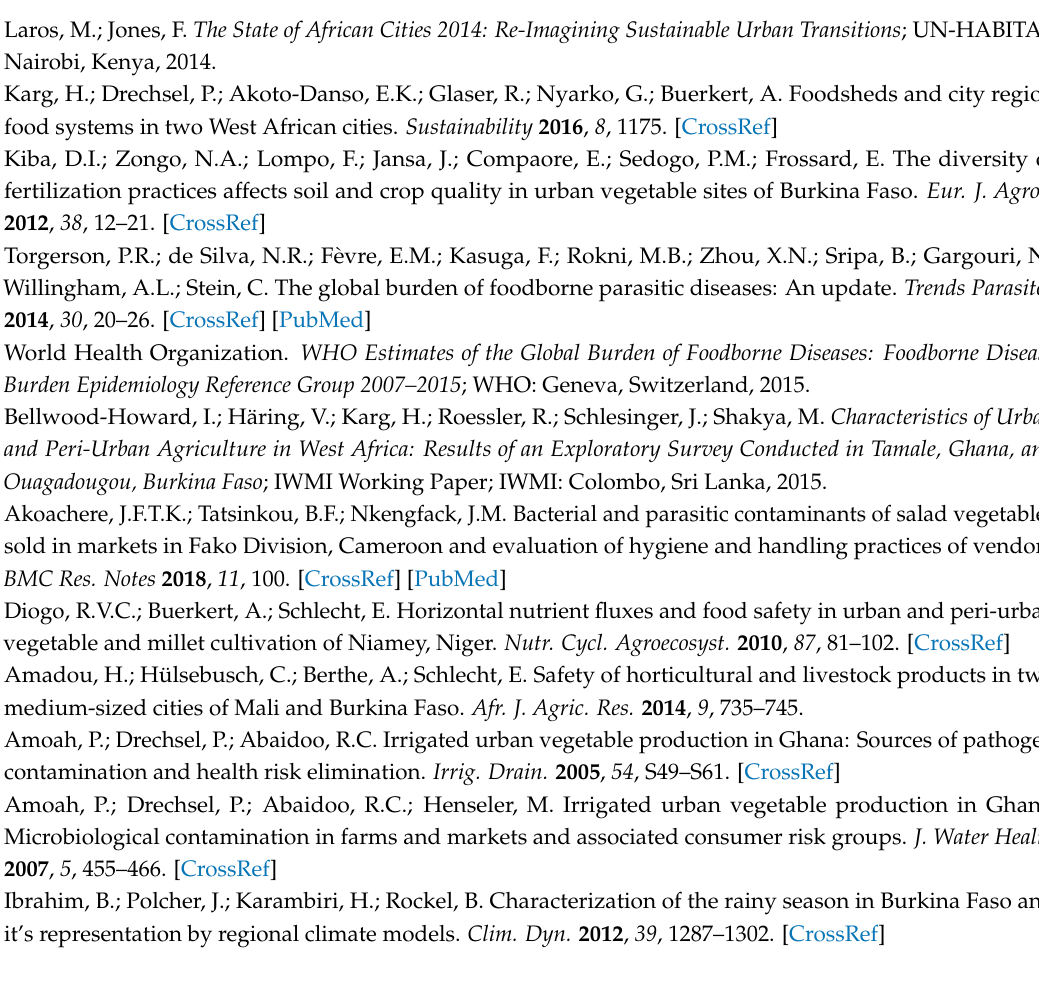
Table S1: Collected data and questions posed during individual interviews in a survey to evaluate post-harvest handling strategies from trading women and vegetable seller on markets and streets in Ouagadougou, Burkina Faso during 2013 and 2014, Table S2: Results of monitoring the post-harvest handling of ten lettuce traders from harvest in urban and peri-urban gardens to their selling points in Ouagadougou, 2014. Author Contributions: J.D. and A.B. Conceptualization; J.D. Data collection; Writing—Original Draft